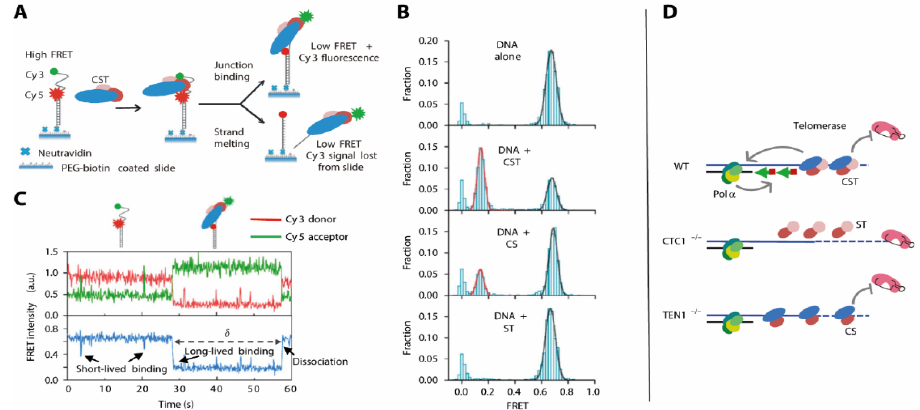
Figure 9. ( A) smFRET construct design to investigate G4 resolvase activity of the CST complexes. ( B ) smFRET data depicting the efficient unfolding of the G4 construct by CST, less efficient unfolding in presence of CS, and no unfolding with ST. ( C ) Time-resolved unfolding and identification of intermediates in presence of CST. ( D ) Model for the interplay between the CST complex and Pol α . This Figure is adapted from Feng et al. [23] and used under Creative Commons Non-Commercial License (CC-BY).